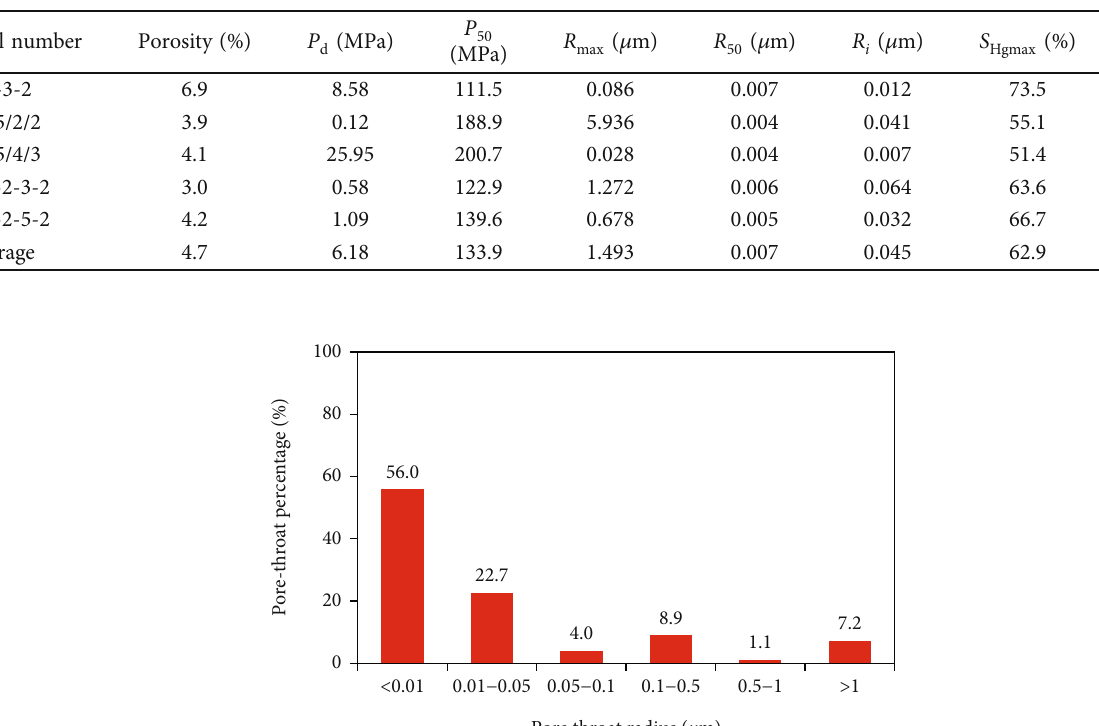
Table 4: Parameters of high-pressure mercury injection for the interlayer samples.